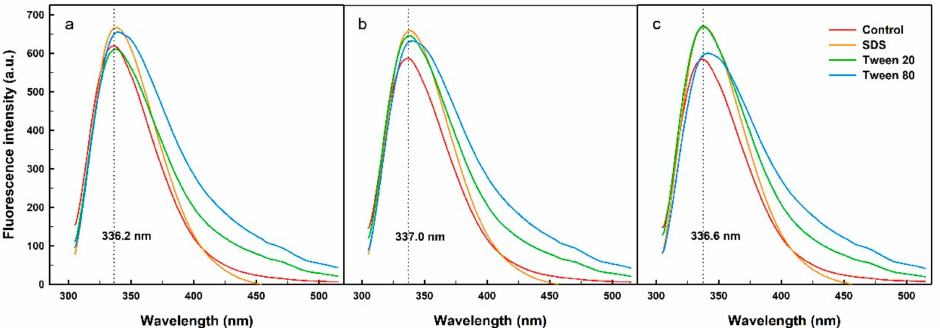
Figure 3. Fluorescence spectra of His 6 -tagged Bd PTE in the absence and presence of 3% ( v / v ) surfactants. Spectral analyses were carried out after one-hour incubation of the enzyme samples at ambient temperature ( a ), 40 ◦ C ( b ), and 60 ◦ C ( c ), respectively, for 1